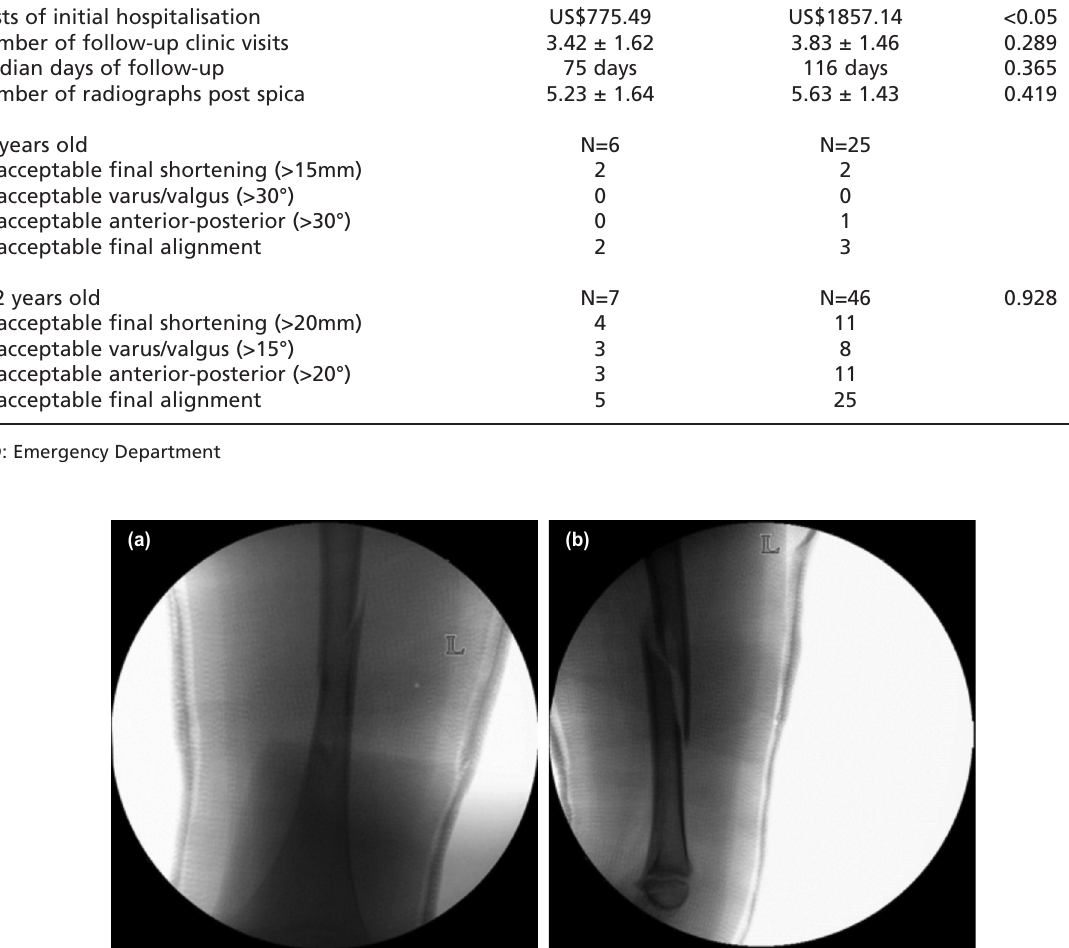
(a,b) Radiographs of the closed reduction and hip spica application of patient Fig. 1: